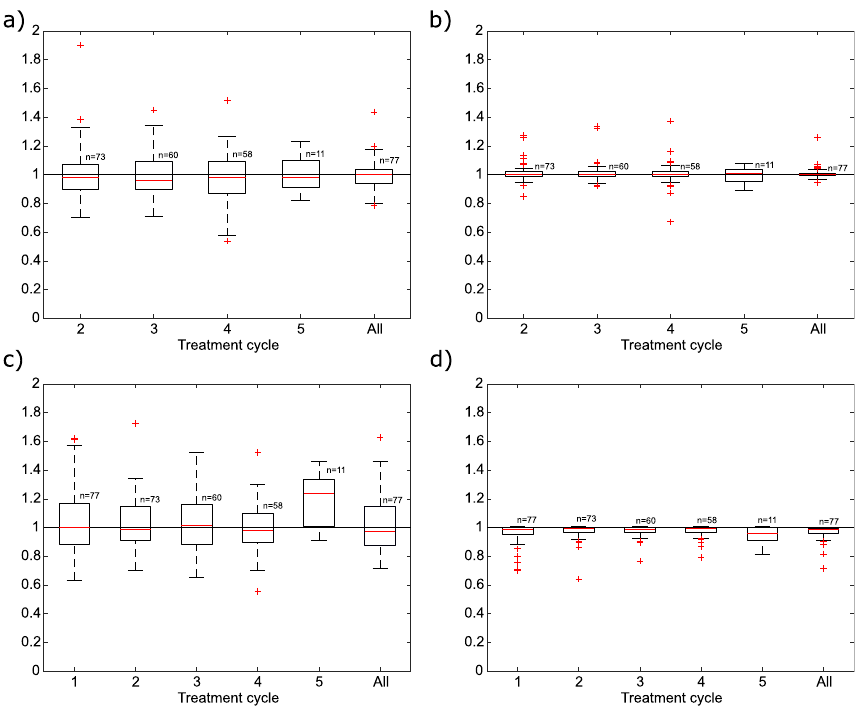
Fig. 4 Absorbed doses to the tumors normalized against “true” absorbed doses. Absorbed doses were calculated using the 1 d images and T eff from the first treatment cycle ( a) , using the 7 d images and T eff from the first cycle ( b) , using the 1 d images and a fixed T eff ( c) , and using the 7 d images and a fixed T eff ( d) . “All” refers to the total absorbed dose from all treatment cycles, n corresponds to number of data points included in the calculation for the corresponding treatment